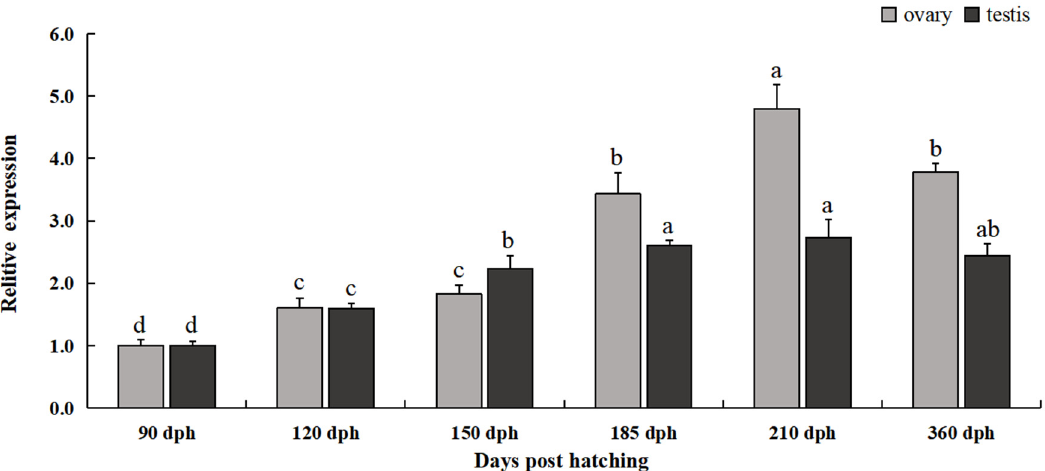
Figure 4. Rcvasa mRNA expression patterns during the first annual gonadal development of cobia. The results are presented as the mean ± SD ( n = 3), and the values with different letters (a–d) appeared significantly different in pairwise comparisons ( p < 0.05).